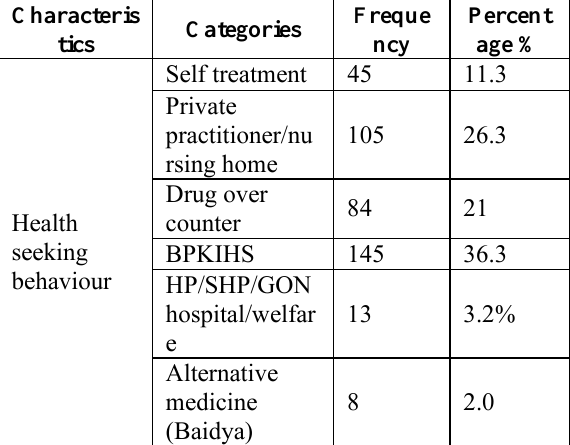
Table 3: The pattern of health seeking habits was evaluated using numerical codes. The subjects opting for: self treatment during illness was 45(11.3%), visit to a private practitioner/ nursing home was 105(26.3%), used of drug over counter from nearest pharmacy